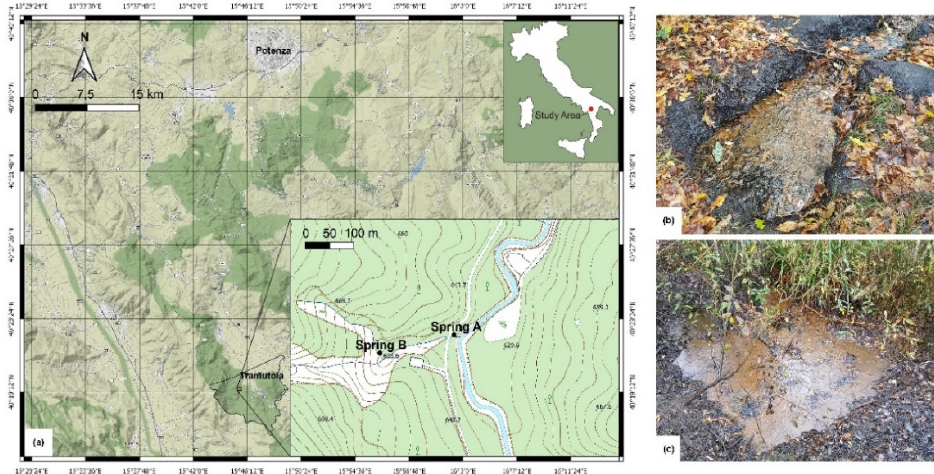
Figure 1. Area of study: ( a ) location of the springs; ( b ) seepage A0 and ( c ) seepage B0 [22,23].